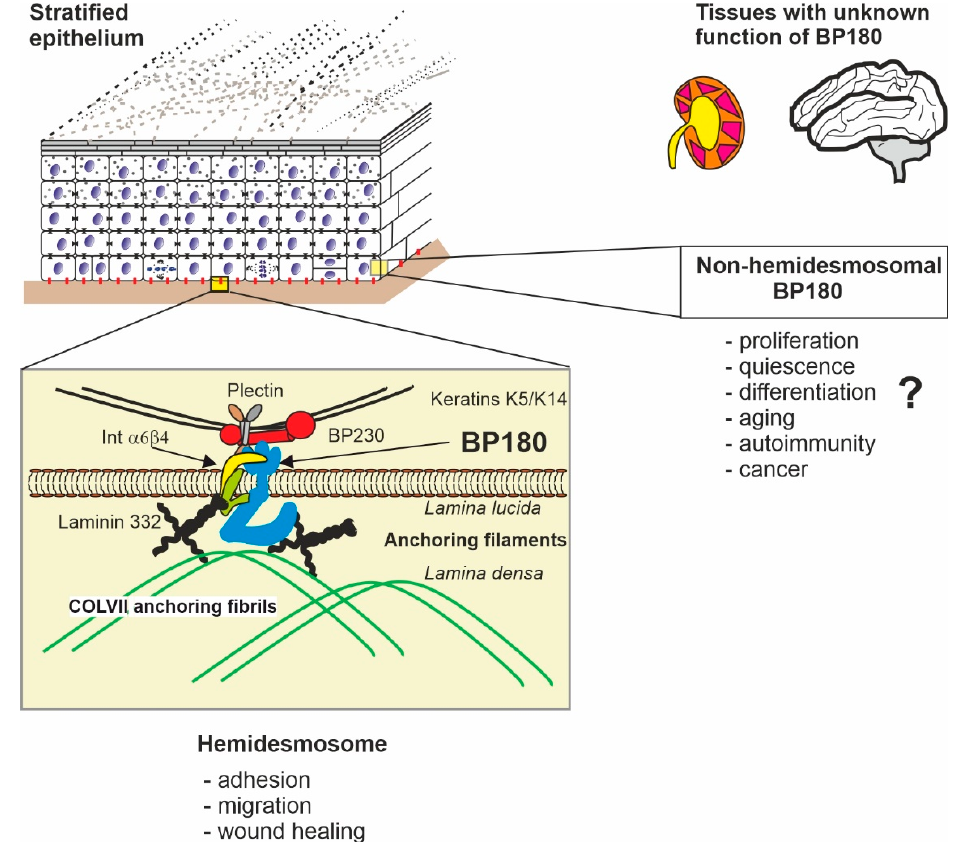
Figure 1. The locations and functions of BP180. The structure, function, and interactions of BP180 (cyan) are best characterized in cutaneous hemidesmosomes (HD, inset box) which create the adhesion between basal keratinocytes (the bottom layer of nuclear cells and the basal lamina (brown line). In HD, BP180 exists as a trimer, with the intracellular domain (ICD) binding to keratin intermediate filaments via plectin and BP230. The extracellular domain (ECD, “ectodomain”) of BP180 binds to integrin alpha 6, laminin-332, and collagen IV, which connect HD to collagen VII anchoring fibrils of the basal lamina. The non-HD functions of BP180 are relatively unknown, as are the functions in non-epithelial tissues such as the kidney and the brain. The sizes of macromolecules are not in scale and their molecular shapes are schematic. The mutual positions describe only roughly the sites of